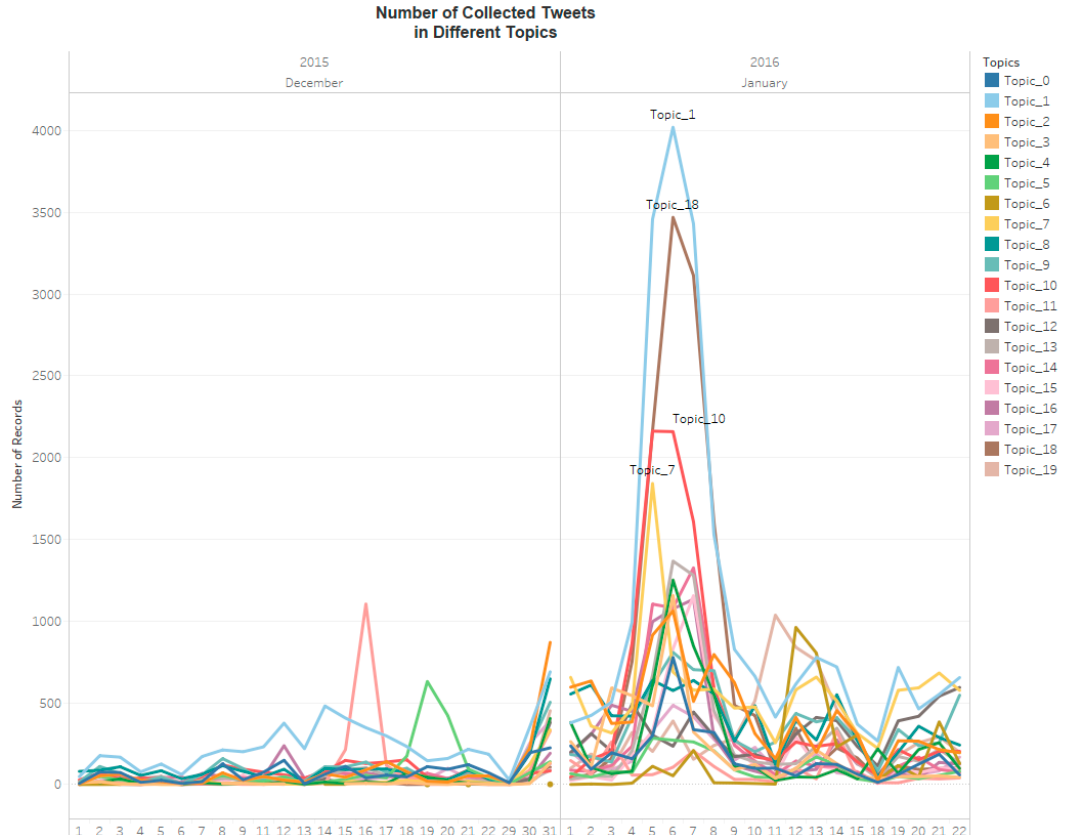
Figure 2. Number of tweets in each topic.